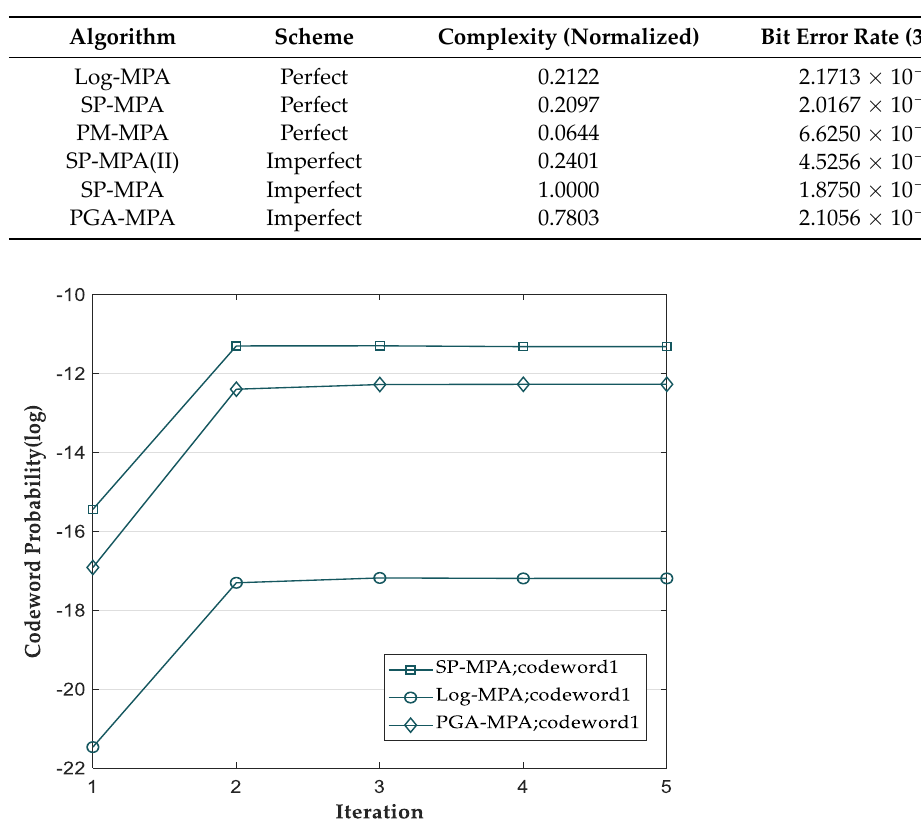
Table 3. Complexity and bit error rate in different algorithms.